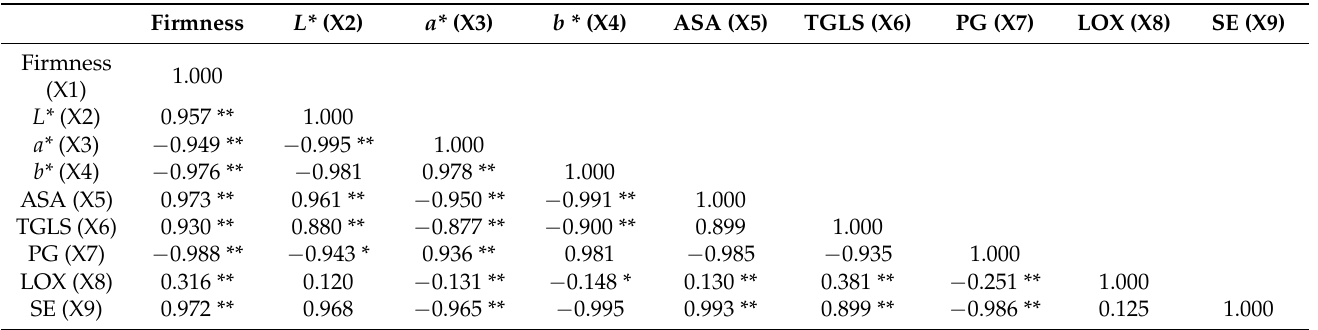
Table 2. Relationship analysis of the quality indicators of fresh-cut “Xuebai” cauliflower florets during